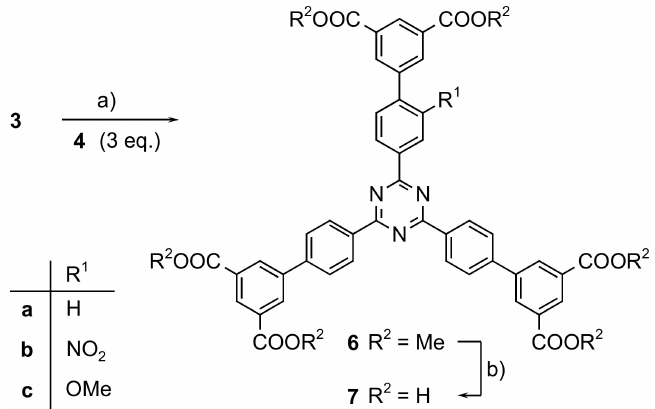
Figure 3. Syntheses of hexadentate mono-substituted triazine based linkers 6 and 7 : a) in dioxane /